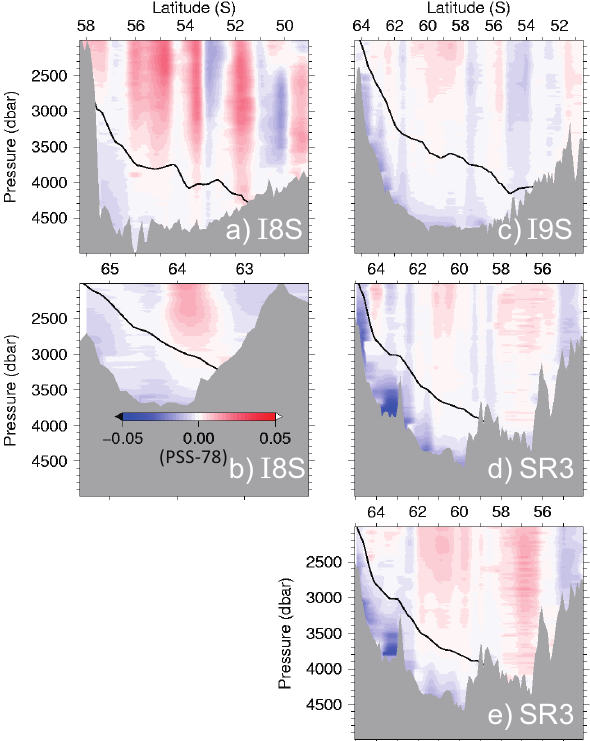
Fig. 5. Difference in isobaric salinity between the WHP and re- peat occupations. Red areas indicate increase in salinity and blue areas indicate freshening. (a) I8S (the Australian-Antarctic Basin), (b) I8S (the PET), (c) I9S, (d) SR3 (obtained from subtracting the WHP from combined repeat occupations in the year 2001, 2002, and 2003), (e) SR3 (obtained from subtracting the WHP from repeat occupations in the year 2008). Mean γ n = 28 . 30kgm − 3 isopycnals are shown by solid